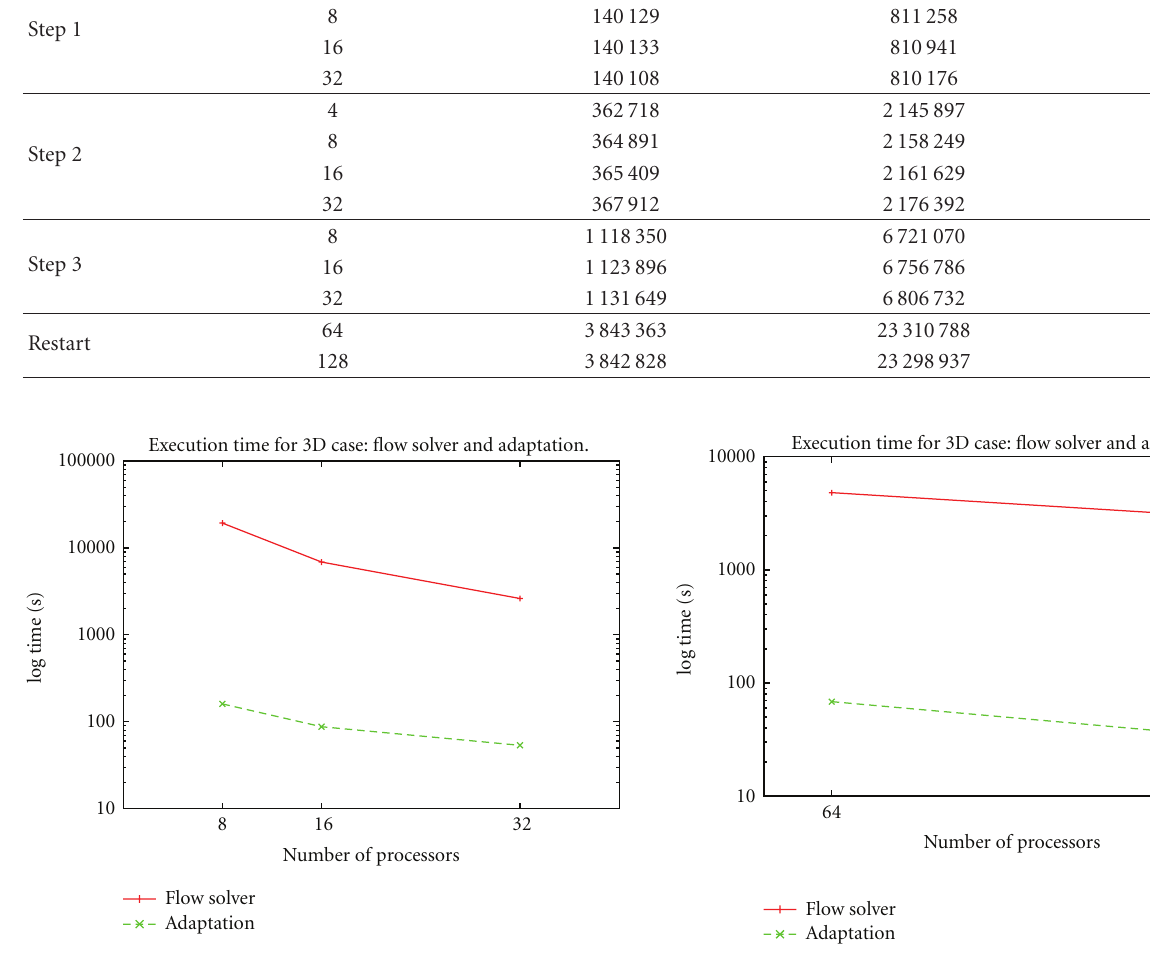
Figure 21: Execution time for flow solver and adaptation process on multiple processors. 3D wedge, three adaptation steps.